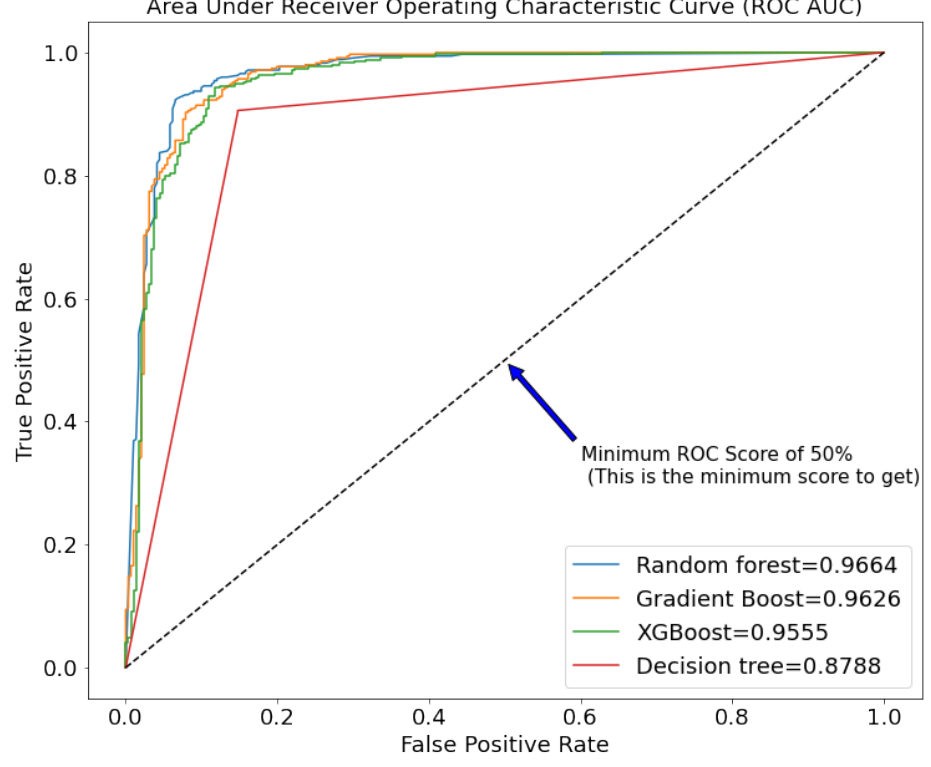
Figure 4. ROC AUC of different tree-based machine learning models after